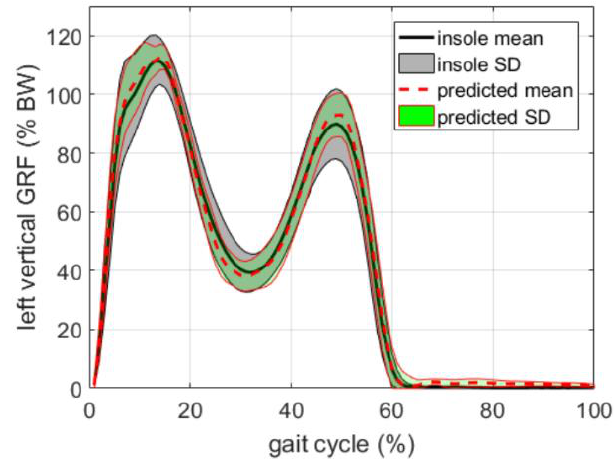
Figure 20. Vertical GRF profile predicted by the method proposed by [87] and the one directly measured by pressure insoles.